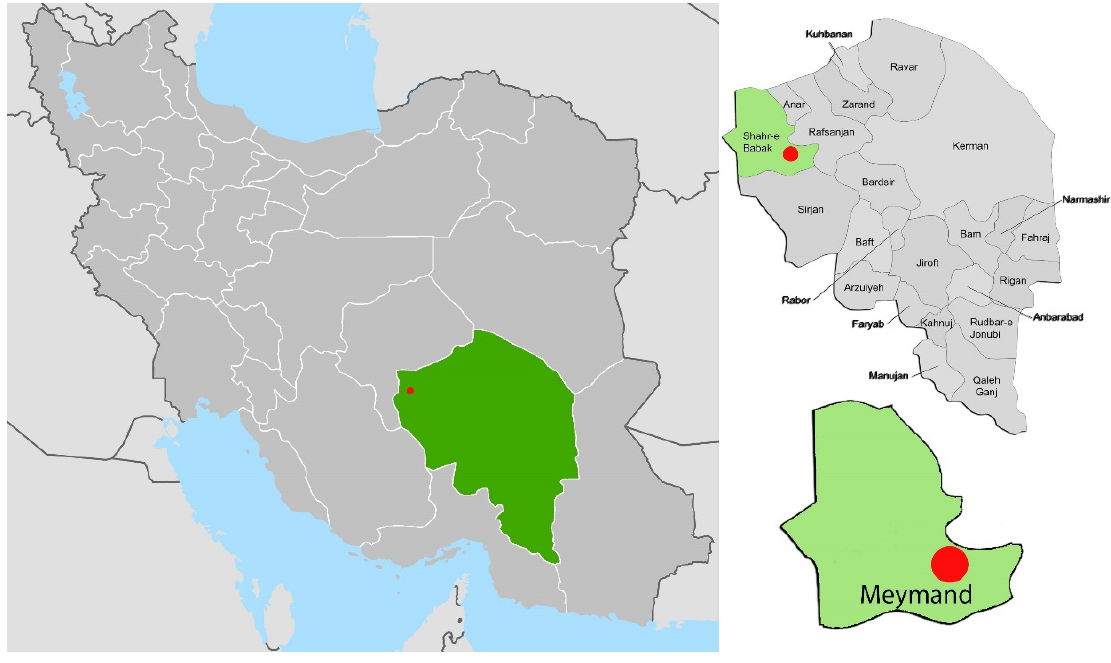
Figure 4. Location map of Meymand in Iran.